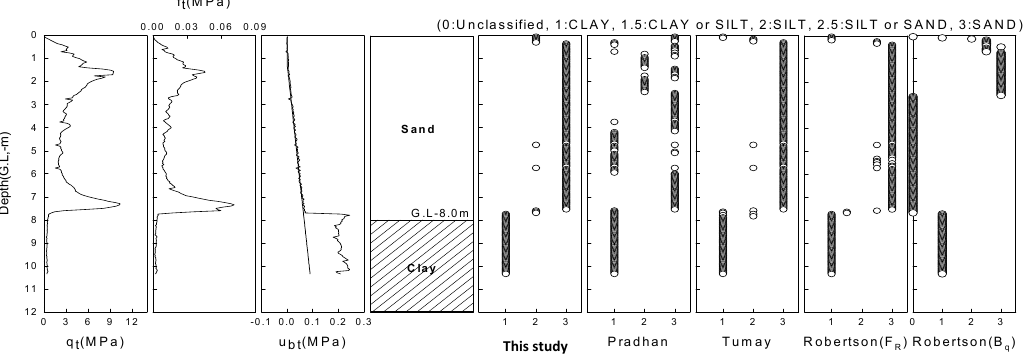
Figure 12. Verification results at Pusan new port support area site.